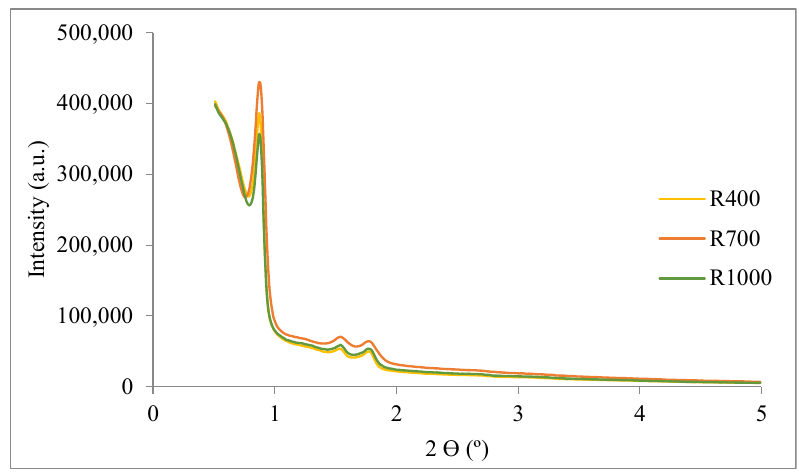
Figure 3. Low angle X-ray diffraction patterns of samples for the study of the influence of stirring rate.